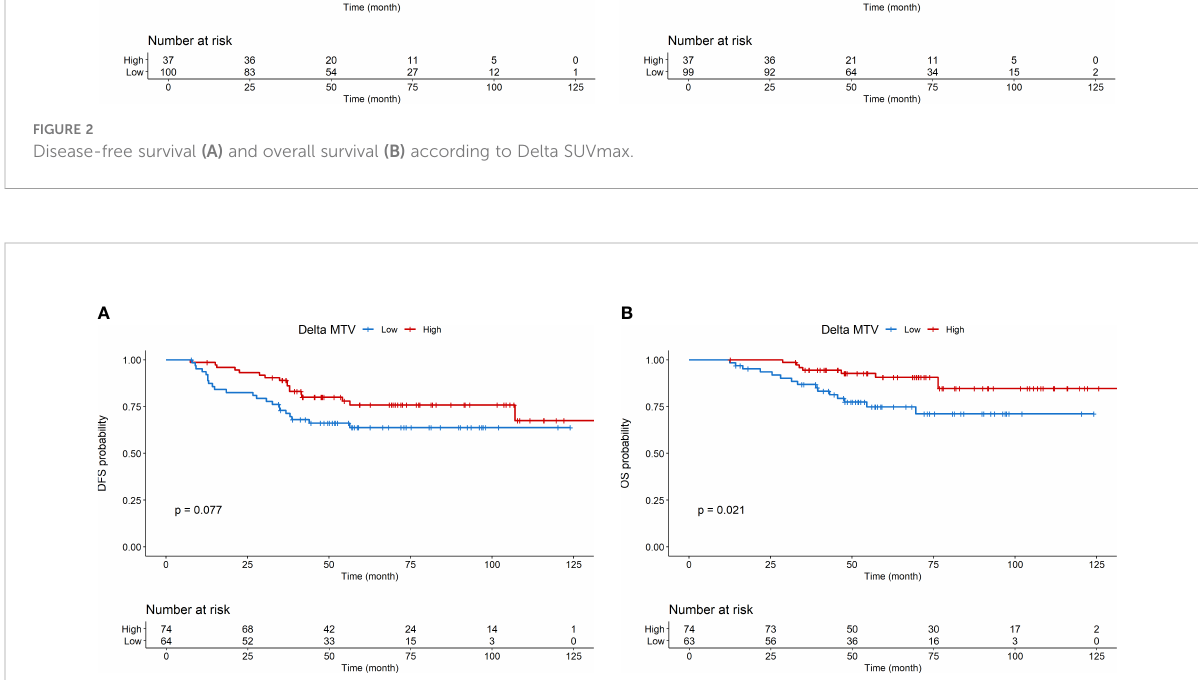
FIGURE 3 Disease-free survival (A) and overall survival (B) according to Delta